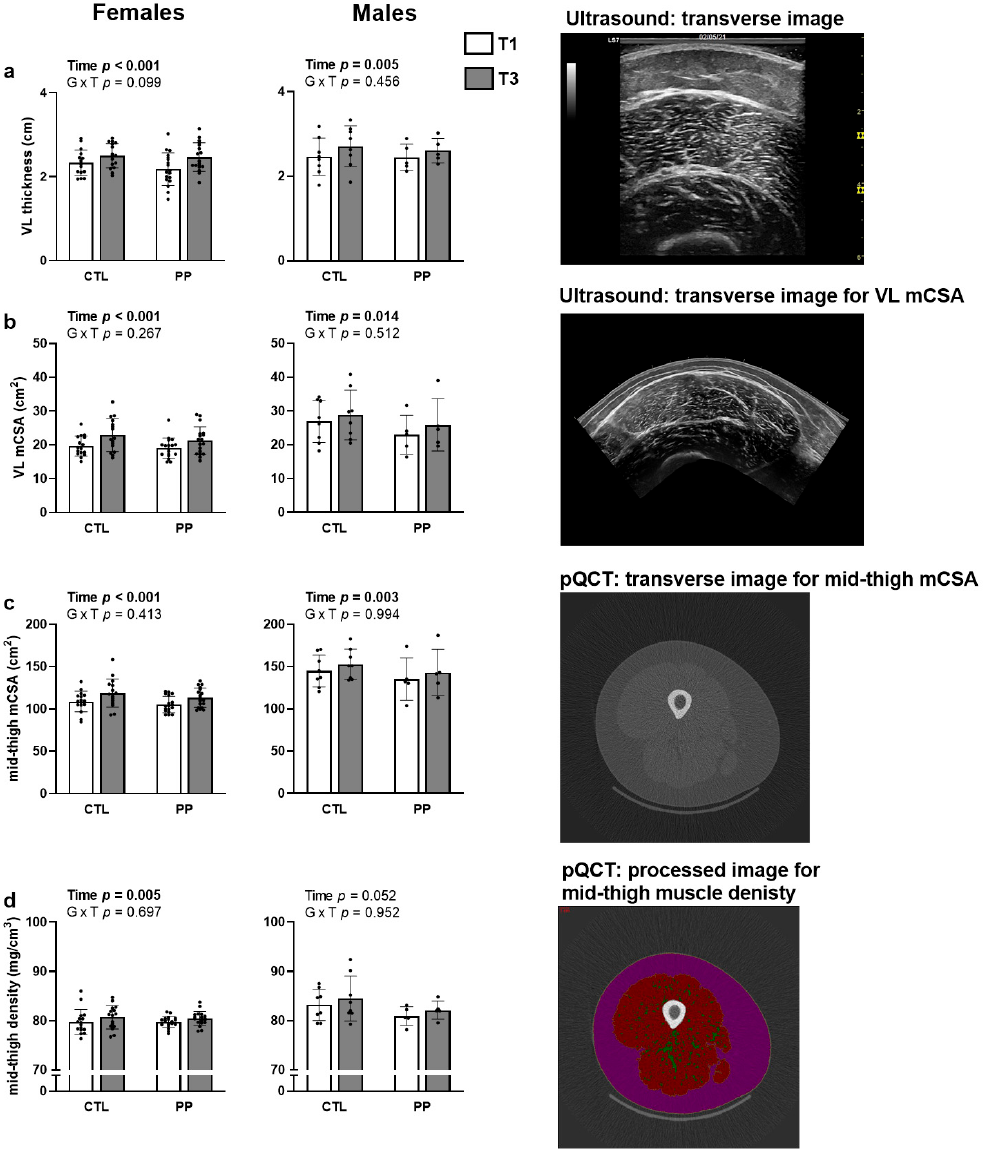
Figure 5. Mid-thigh muscle adaptations. Data include vastus lateralis (VL) thickness ( a ), vastus lateralis muscle cross- sectional area (mCSA; ( b )), mid-thigh mCSA ( c ), and mid-thigh muscle density ( d ). Representative images of each technique are provided to the right of each bar graph. All data are presented as mean ± standard deviation values. Other abbreviations: PP, peanut protein group; CTL, control group. Symbol: • , indicates individual respondent